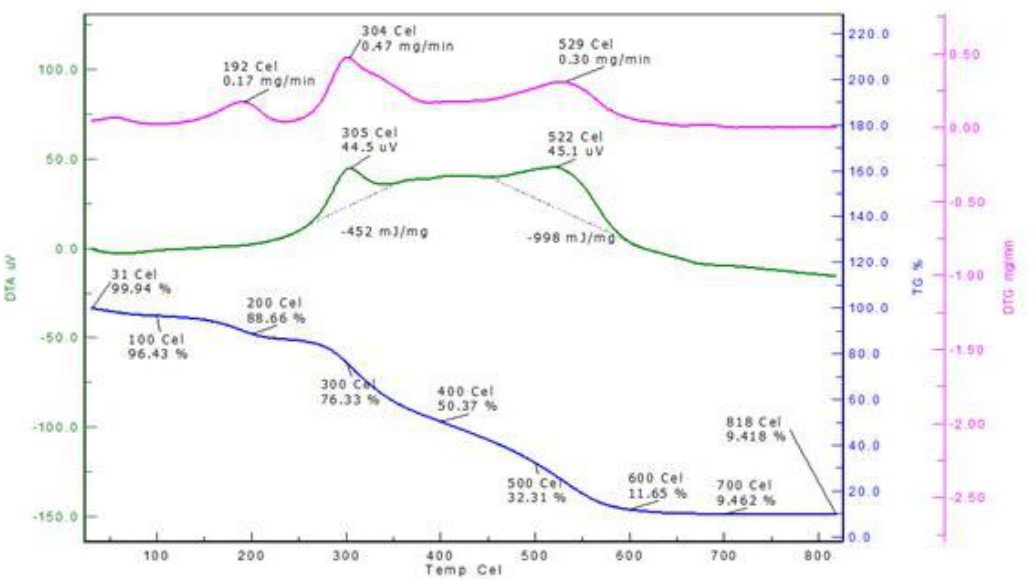
Figure 12: Thermal analysis of 20 wt% RH (8% NaOH treated) + 1 wt% RHA reinforced